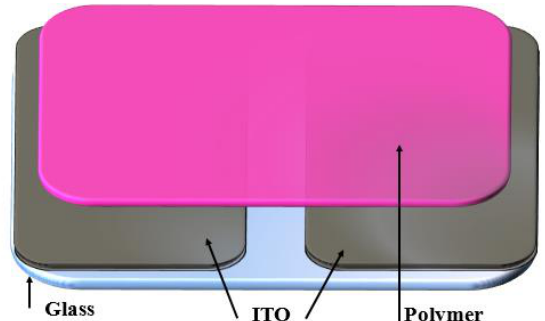
Figure 1. Sample configuration (used for electrical measurements). Reprinted with permission from [20]; Copyright 2013 Elsevier.